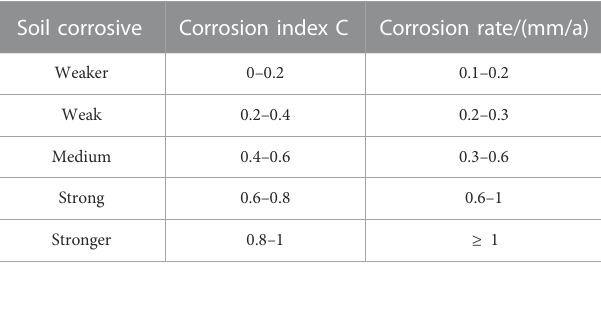
TABLE 2 Soil corrosion and average corrosion rate. TABLE 3 Classi fi cation reference of corrosion